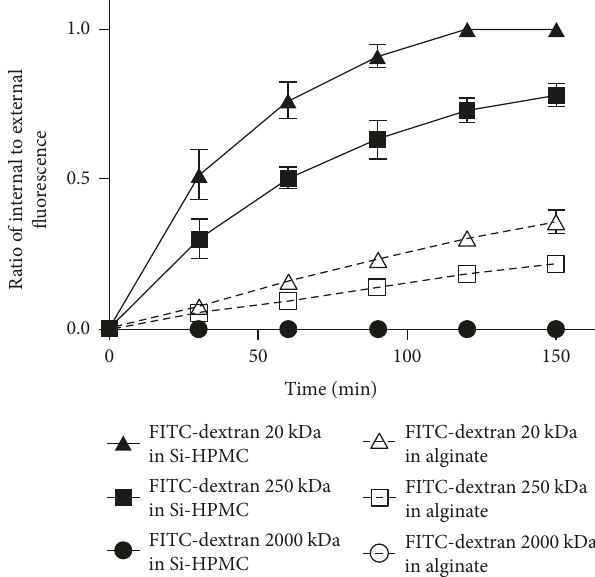
Figure 2: Alginate and Si-HPMC particle di ff usion properties. Alginate and Si-HPMC particles were incubated in fl uorescently labeled FITC-dextran (Mw 20, 250, and 2000 kDa) solutions for 2h and 30min. Fluorescence intensities of particles (inside) and FITC- dextran solutions (outside) were assessed by confocal microscopy. A ratio of internal to external fl uorescence was then calculated, and a ratio of 1 indicating that fl uorescence intensity was identical in a particle and the surrounding solution. Alginate and Si-HPMC particles of 1 mm diameter were selected for this study. Each test was performed for one particle at a time and repeated at least 3